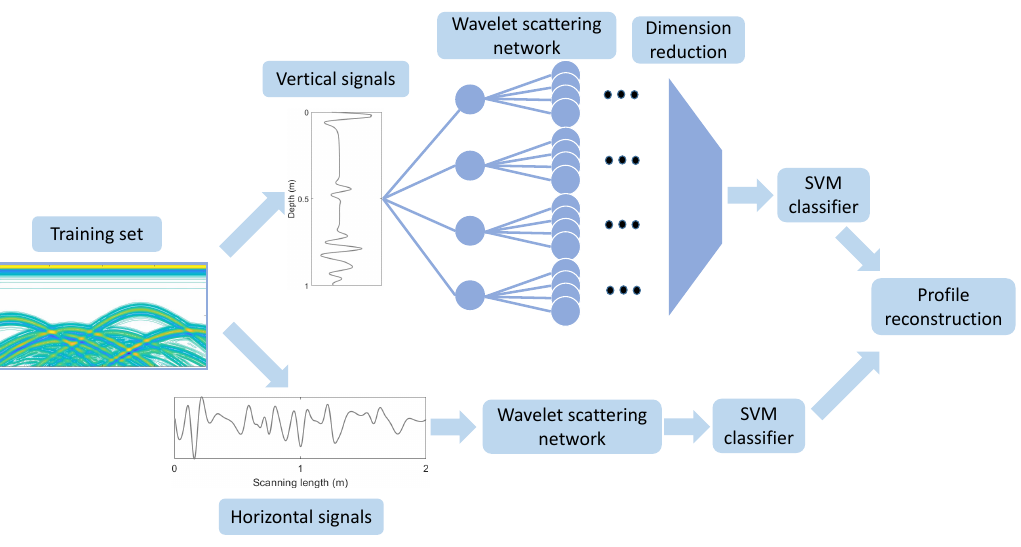
Figure 7. The machine learning architecture for pipeline identification.